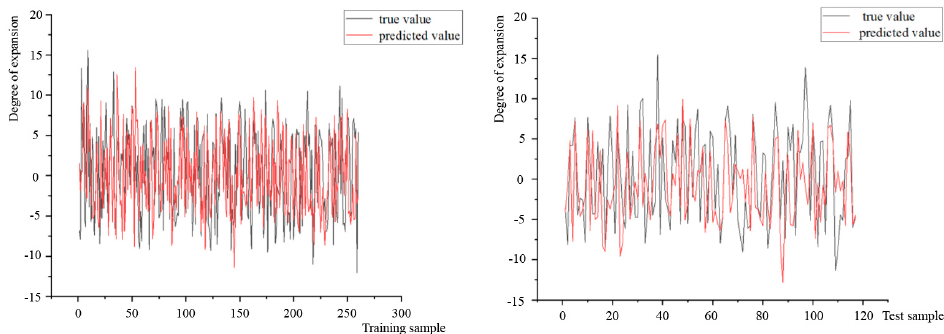
Figure 8. Running results of the BP neural network model.